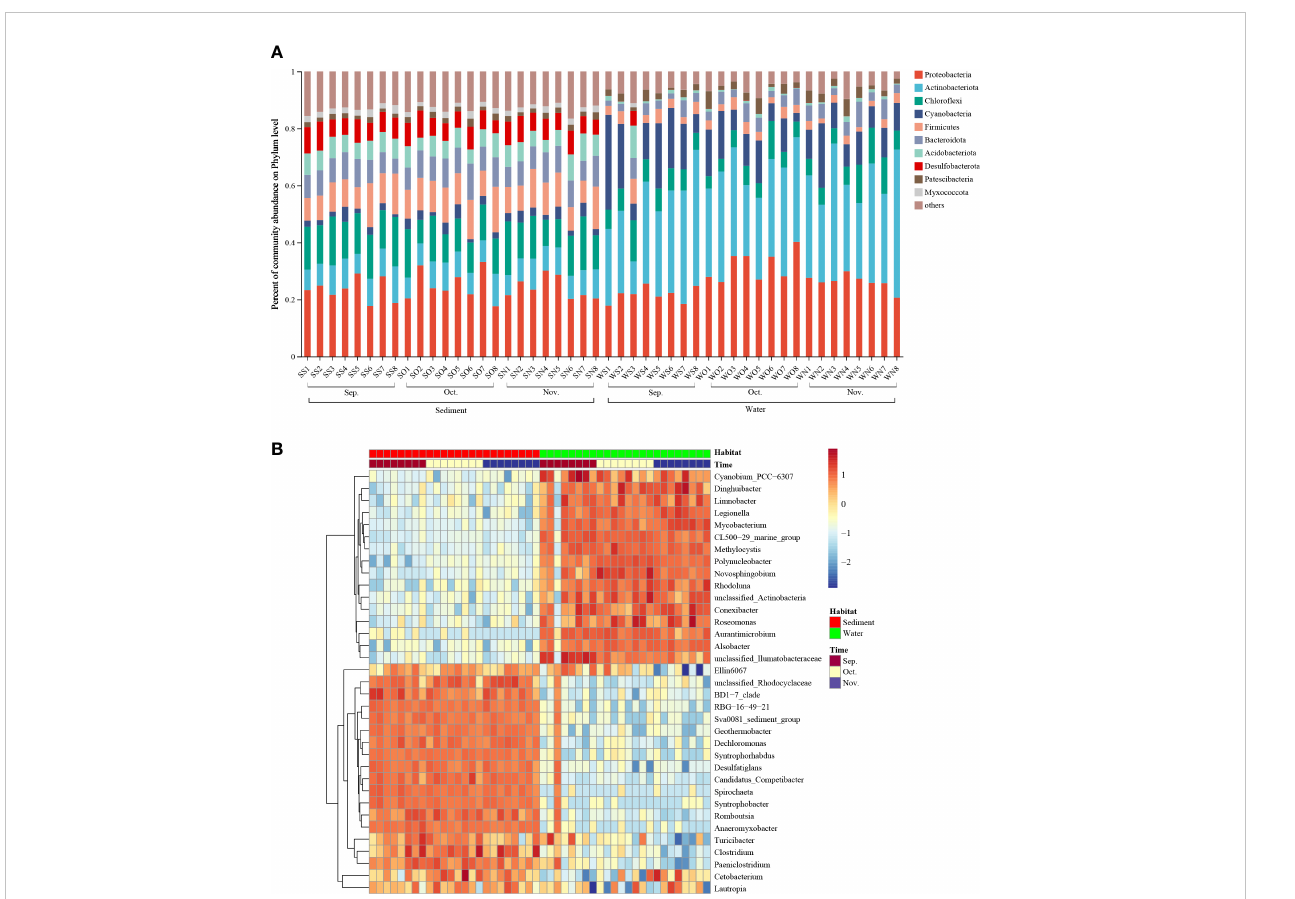
FIGURE 2 Relative abundance of dominant phyla and genera. (A) Relative abundance of dominant phyla in all communities. (B) Relative abundance of dominant phyla in 3 months. Rows represent the 35 most abundant bacterial genera, and the square-root-transformed relative percentage of each genus is depicted by color intensity. Sep., September; Oct., October; Nov.,